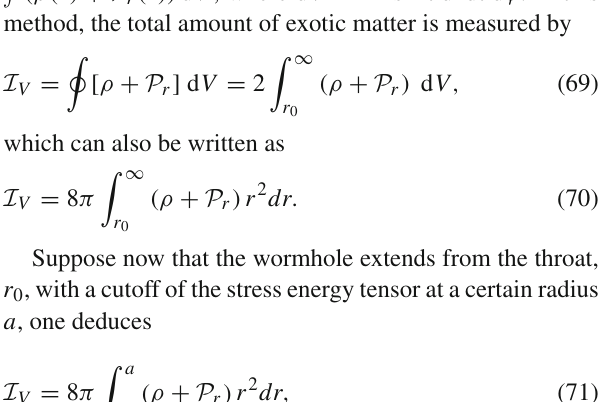
Fig. 10 The plot depicts the ‘volume-integral quantifier’ associate with model C & D in Sect. 3. It is clear that when a → r + We consider the same set of values as of Figs. 3 and 4 with a = 2